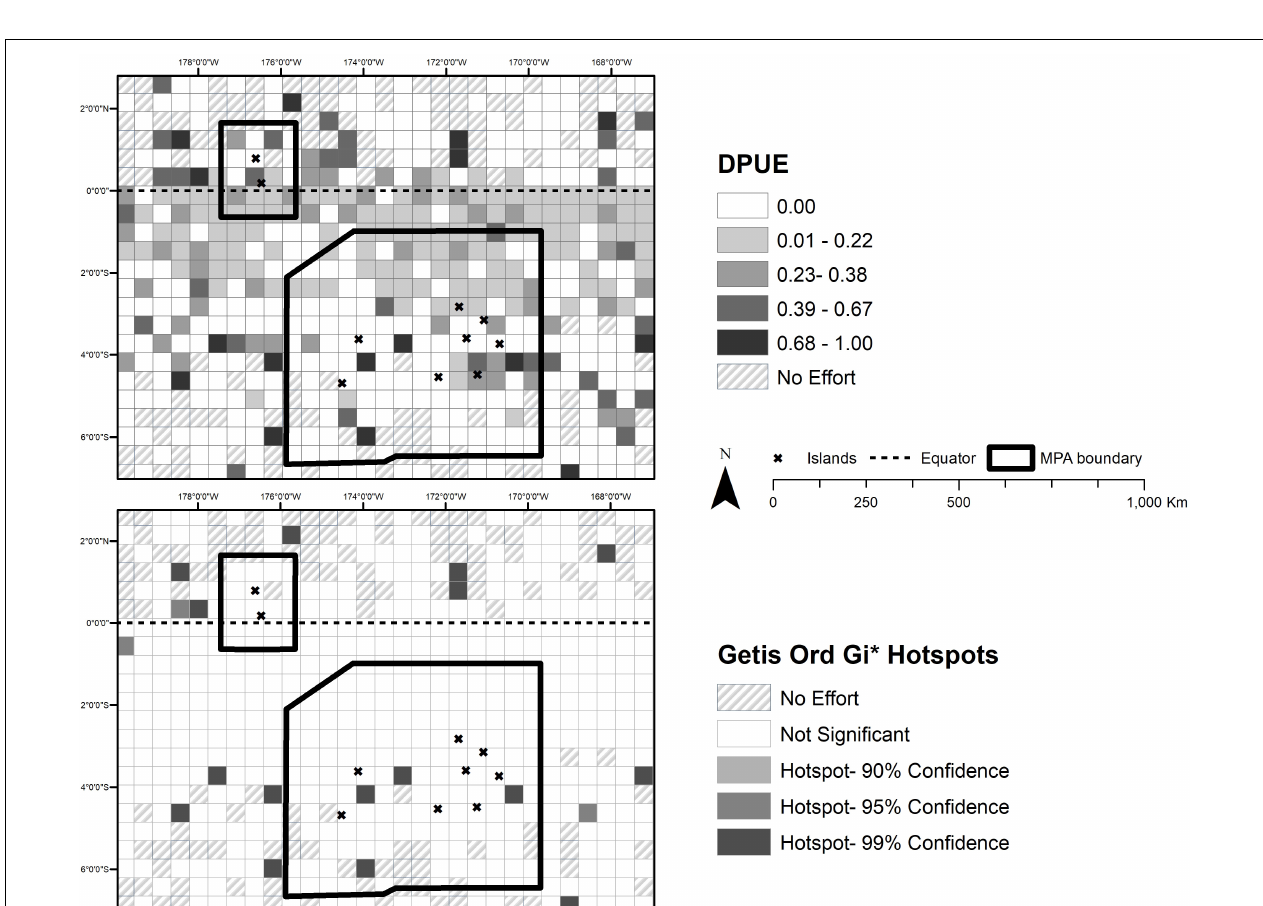
FIGURE 4 | (Top panel) Detections of whales per unit whaling effort (DPUE) for the entire historical data set. (Bottom panel) Getis Ord Gi* hotspot analysis showing areas of particular frequent sperm whale sightings.